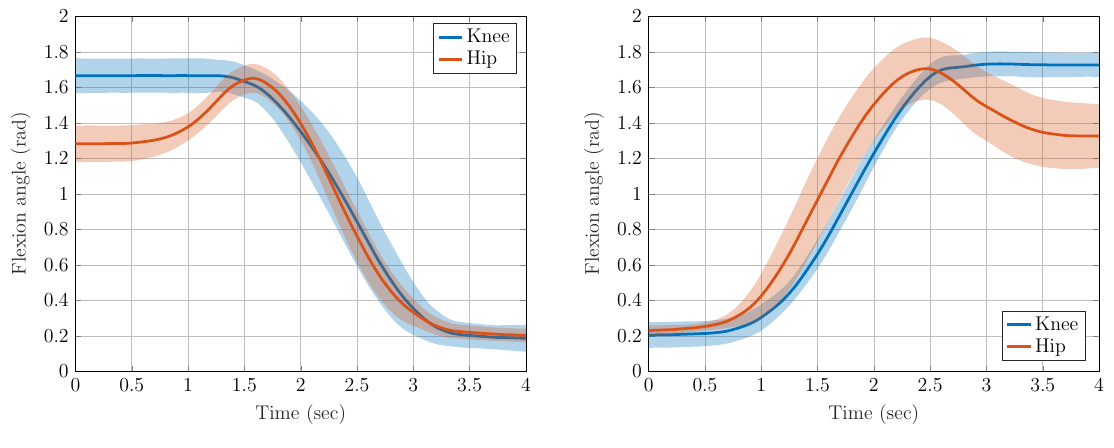
Figure 7. Mean value and standard deviation of joint angles and for hip and knee during sit-to-stand ( left ) and stand-to-sit ( right ), measured on four healthy